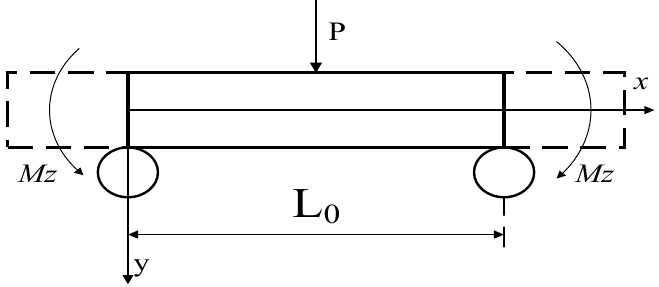
Figure 1. Loading of the carbon fiber reinforced plastics (CFRP) specimen.